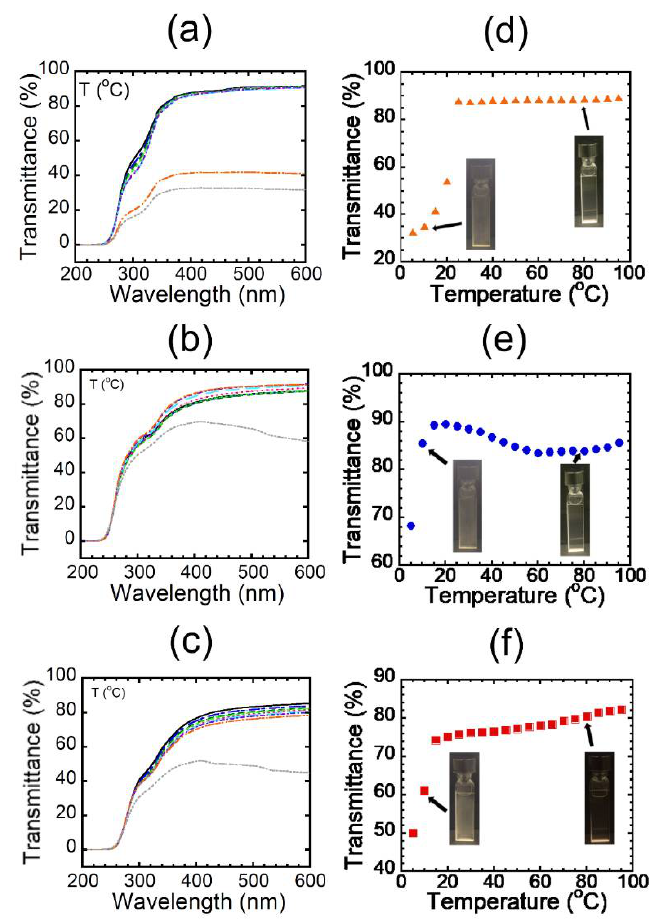
Figure 5. UV-vis spectra of ( a ) HE-Pep, ( b ) Pr-Pep, and ( c ) Me-Pep at various temperatures and the temperature dependence of transmittance of ( d ) HE-Pep (orange triangle), ( e ) Pr-Pep (blue circle), and ( f ) Me-Pep (red square) at 450 nm (1.5 wt %).